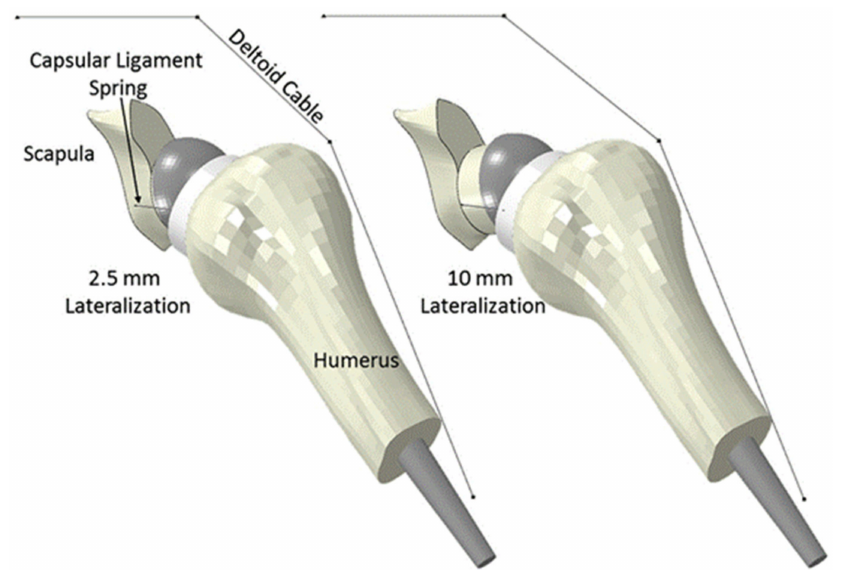
Figure 6. An FE model of the shoulder after RTSA that represented soft tissue tension around the glenohumeral joint capsule with spring elements, and the deltoid as a cable and pulley system [43,75]. To simulate physiological joint loading, one study built multi-body models to inves- tigate the influence of rotator cuff tears on joint stability after RTSA [28] (Figure 1). A rigid body model was used to predict muscle forces during scapular-plane abduction and sagittal-plane flexion under different rotator cuff tear conditions, and these muscle forces were then used as inputs into an FE model of the reverse shoulder. It was shown that full- thickness tears to the infraspinatus significantly reduced glenohumeral joint compression by disrupting the rotator cuff muscle transverse-plane force couple, which may ultimately lead to glenohumeral joint